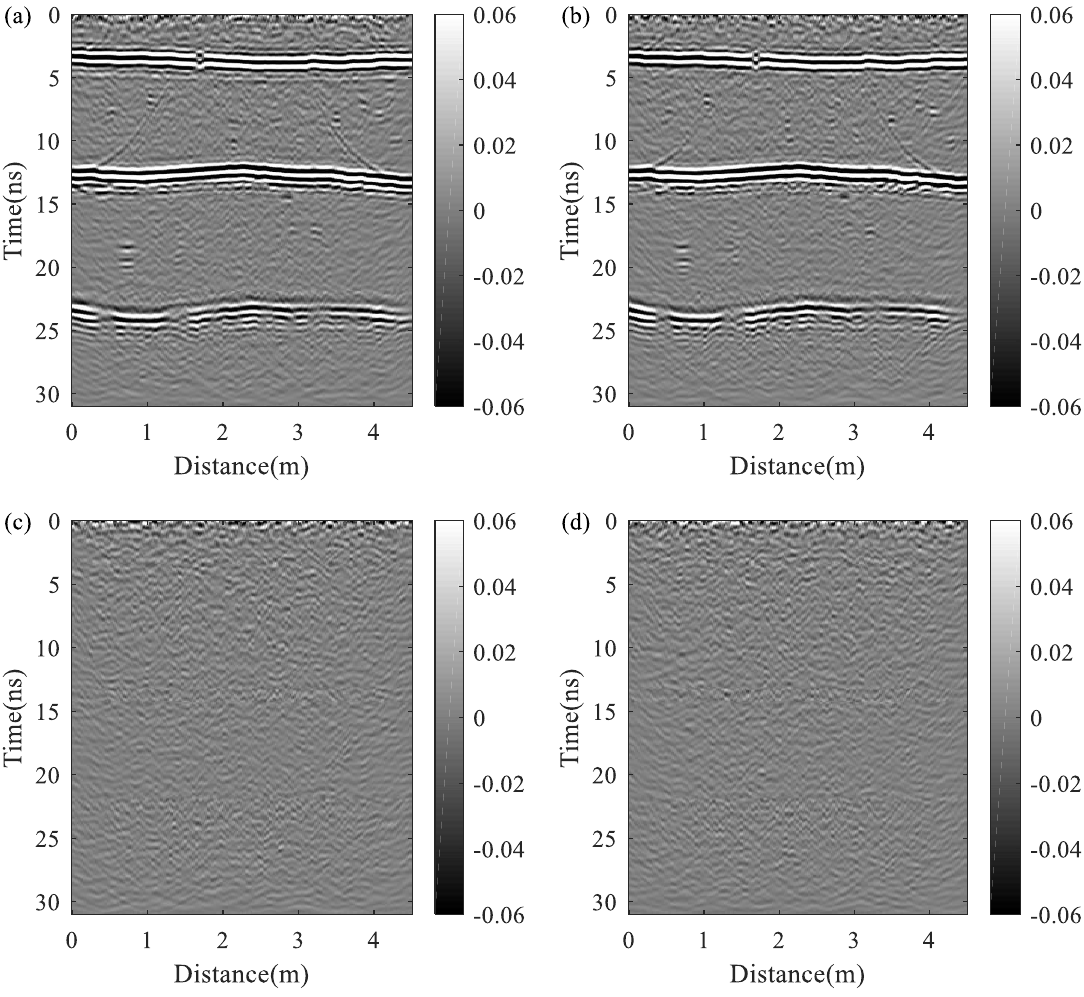
Figure 3. Profiles of preliminary processed FP-SPR data. ( a ) VV mode. ( b ) HH mode. ( c ) VH mode. ( d ) HV mode.